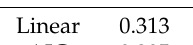
Table 7. Comparison of RMSE between the two models.